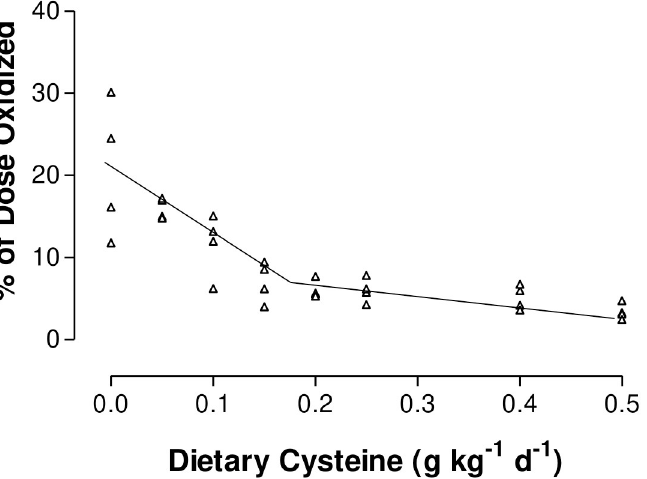
Fig 1. L-[1- 14 C]Met oxidation as a percentage of dose, representing the change in Cys synthesis, in enterally fed piglets receiving graded levels of Cys and 0.25 g kg -1 d -1 Met. The break-point value was 0.15 g kg -1 d -1 with a confidence interval of 0.11–0.20 g kg -1 d -